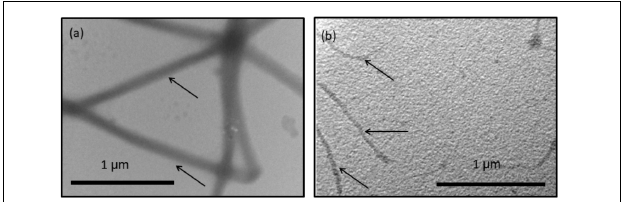
FIGURE 6 | Transmission electron microscopy (TEM) observation of collagen fibers treated with (a) no hrMMP-1 and (b) hrMMP-1. The treatment of hrMMP-1 degraded the collagen fibers and made the fibers thin. Black arrows indicate the collagen fibers.